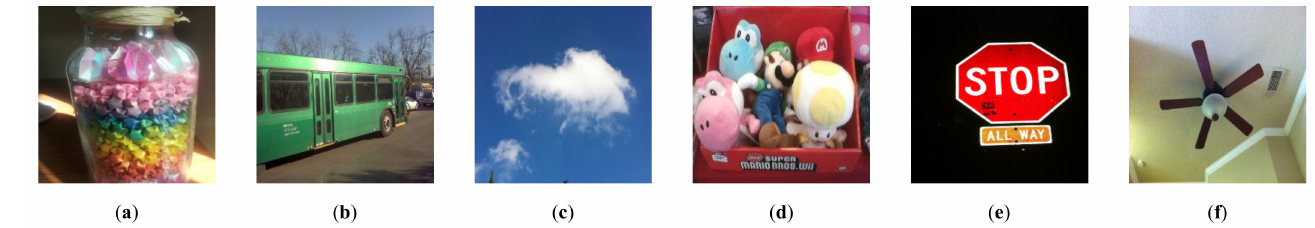
Figure 9. ( a – f ) are the distorted images from the authentic dataset LIVE Challenge.